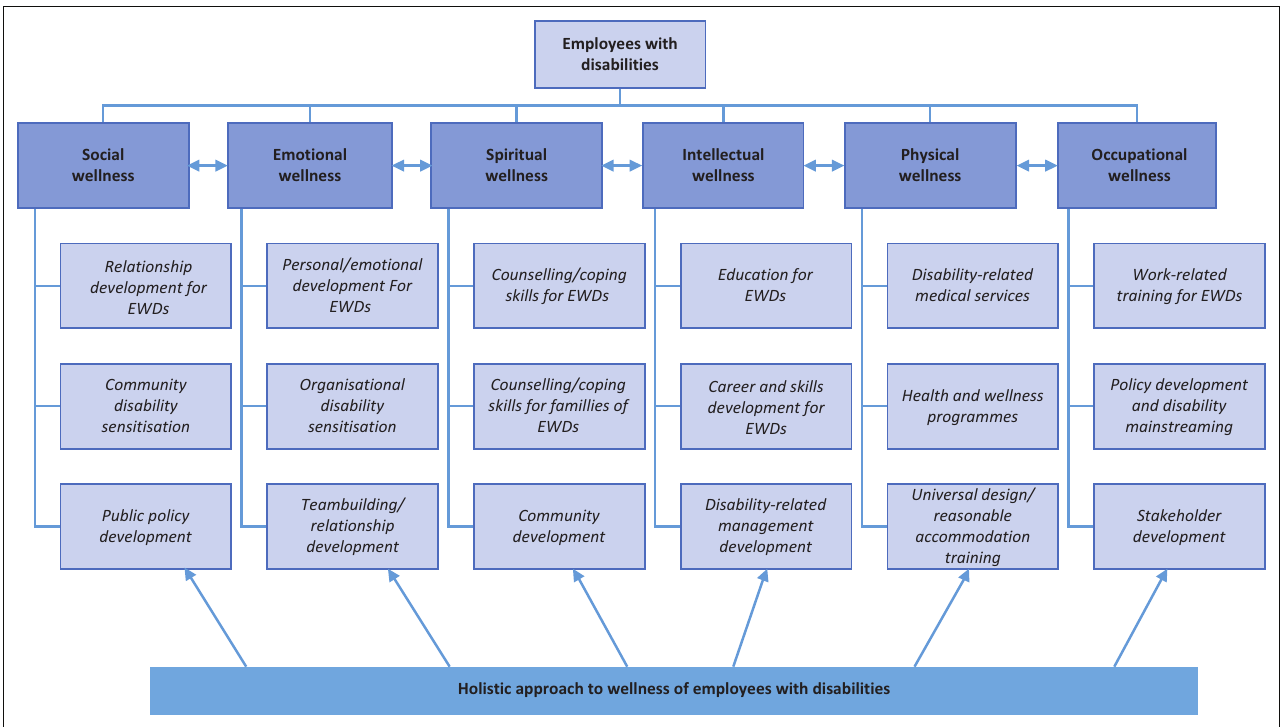
FIGURE 2: Wellness framework for employees with